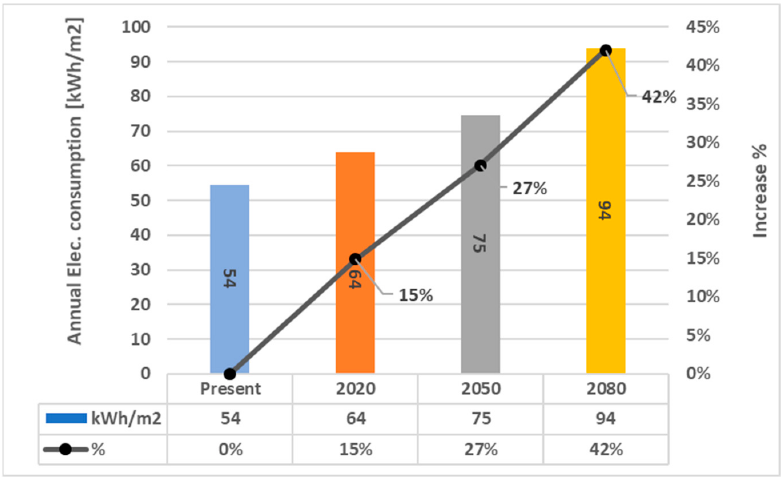
Figure 12. Predicted increase in the annual electricity consumption in Hurghada. After repeating the simulation campaign using the predicted future weather files, the rankings of the alternatives remained unchanged; the scores were noticed to be slightly changing in favor of the higher insulated alternatives, as shown in Figure 13. This is due to the projected increase in the cooling loads and the electricity prices.